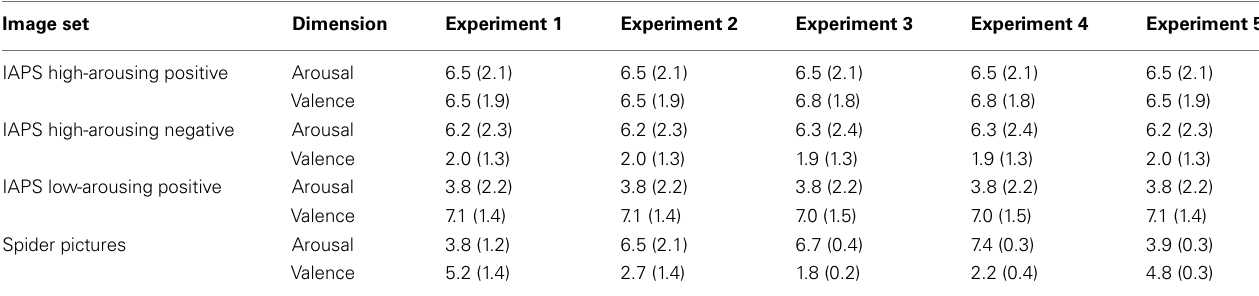
Table 2 | Mean arousal and valence (standard deviation shown in parenthesis) of the four image sets used in Experiments 1–5.